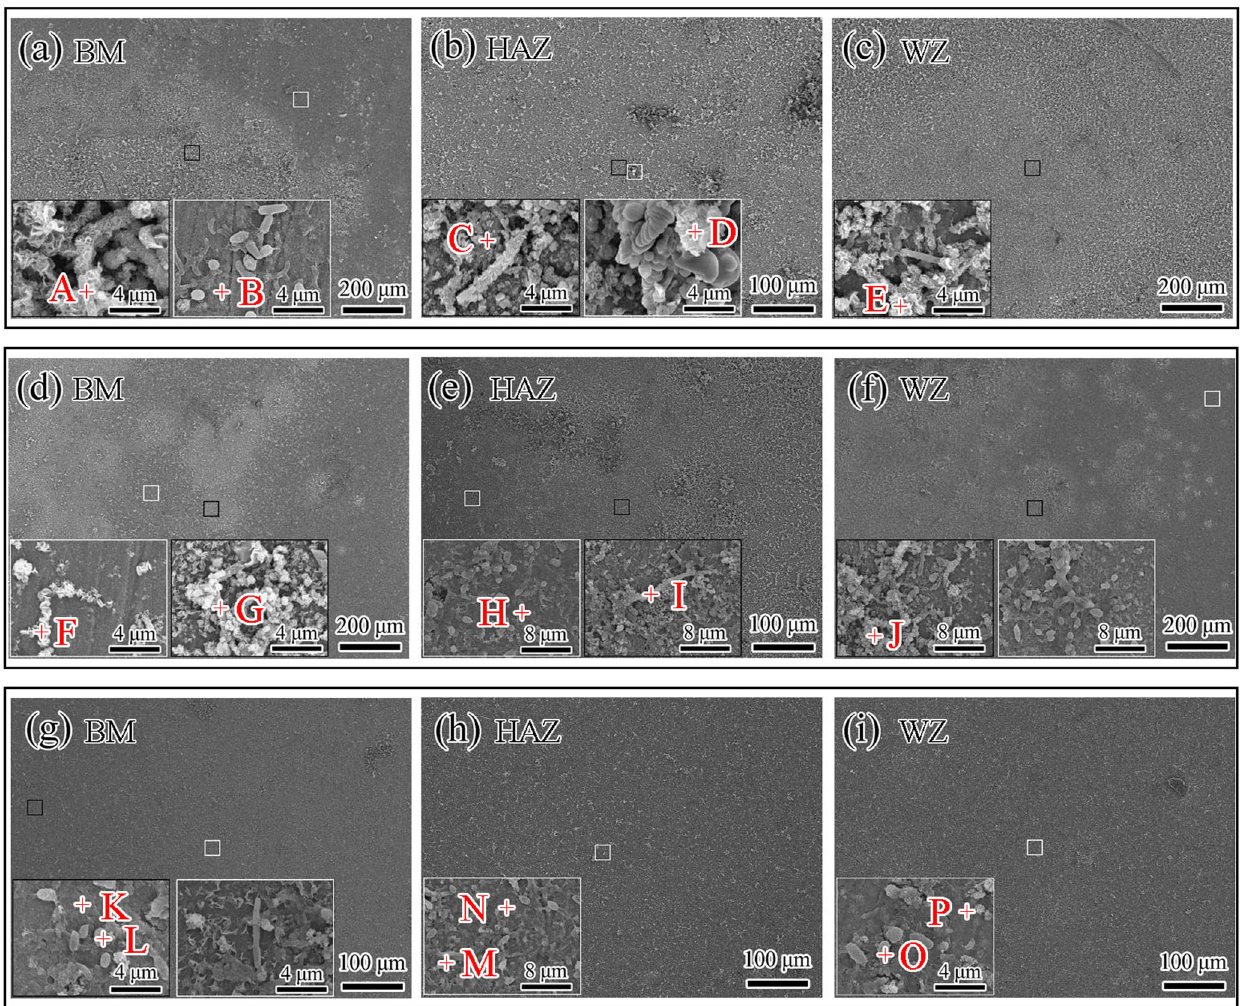
Fig. 3 Micro-morphologies of corrosion products on welded joints after 30 d immersion. a – c Show the micro-morphologies of corrosion products on the surfaces of BM, HAZ, and WZ zones in the medium with 0% organic carbon sources level. d – f Show the micro-morphologies of corrosion products on the surfaces of BM, HAZ, and WZ zones in the medium with 1% organic carbon sources level. g – i Show the micro- morphologies of corrosion products on the surfaces of BM, HAZ, and WZ zones in the medium with 100% organic carbon sources